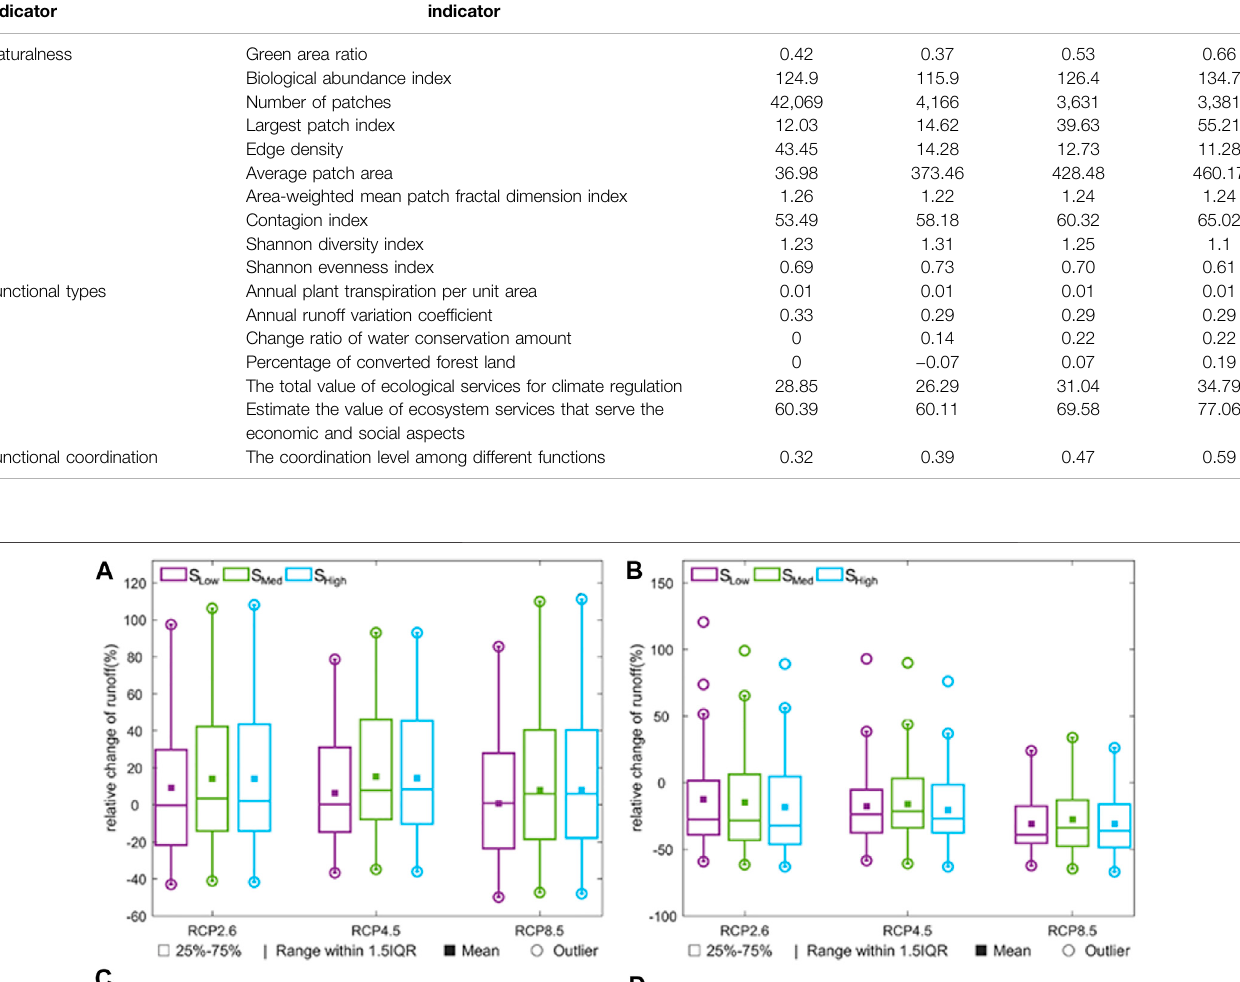
Frontiers in Earth Science |